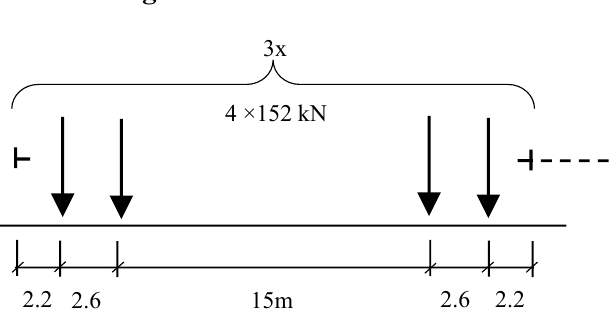
Figure 16. S1 train load